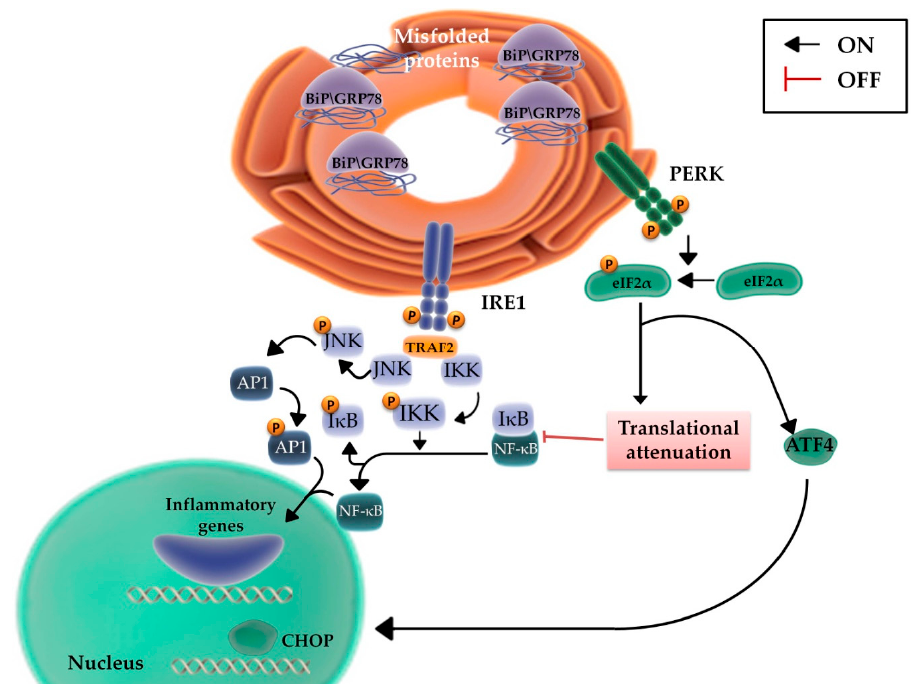
Figure 4. UPR-associated inflammatory signaling pathways. The activation of NF- κ B requires the phosphorylation of its inhibitor, I κ B α , via IKK, leading to I κ B α proteasome degradation and the consequent release of NF- κ B in its active form. During ER stress, activated IRE1 forms a complex with TRAF2 and activates IKK, which in turn induces I κ B degradation, the subsequent activation of NF- κ B and the transcription of pro-inflammatory genes. TRAF2 also induces the phosphorylation of JNK and the up-regulation of other pro-inflammatory genes through activated AP1. Furthermore, activated PERK promotes NF- κ B activation via translational attenuation of I κ B [69].